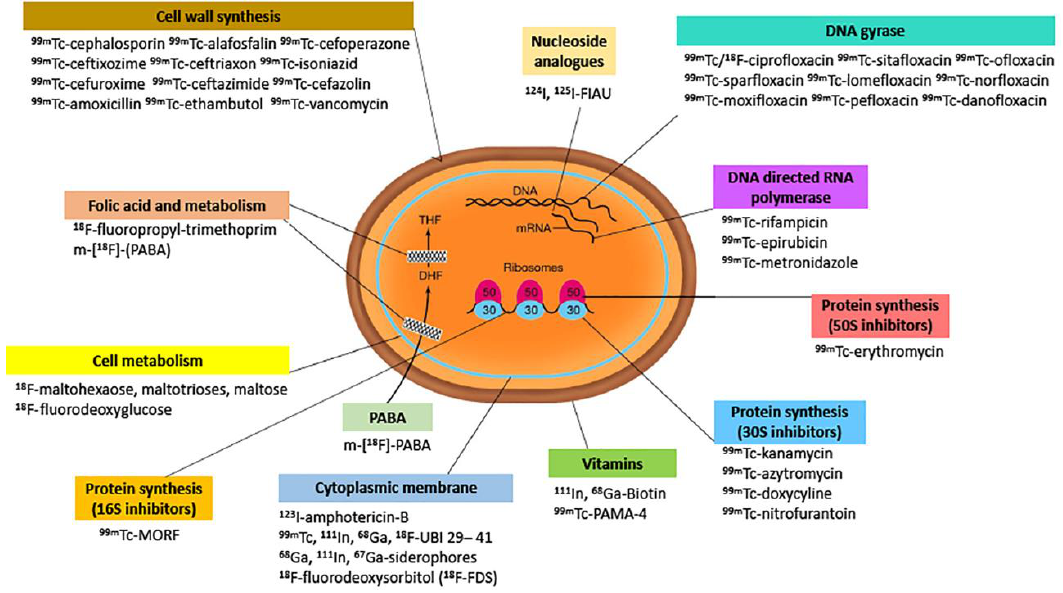
Figure 1. Schematic representation of most radiopharmaceuticals proposed for targeting bacteria, according to their mechanism of action. However, none are able, in humans, to differentiate between infection and inflammation with high diagnostic accuracy (>95%).